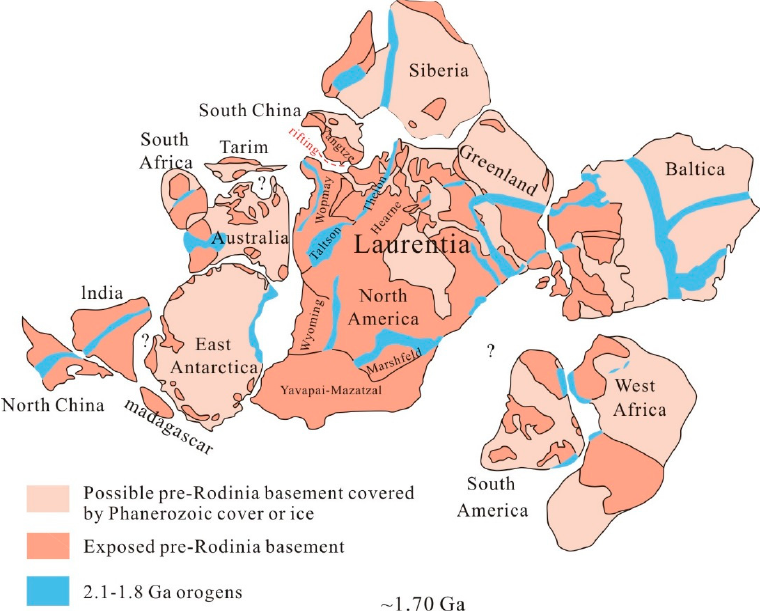
Figure 12. Reconstruction of the proposed Columbia supercontinent (modified after paper [21]).